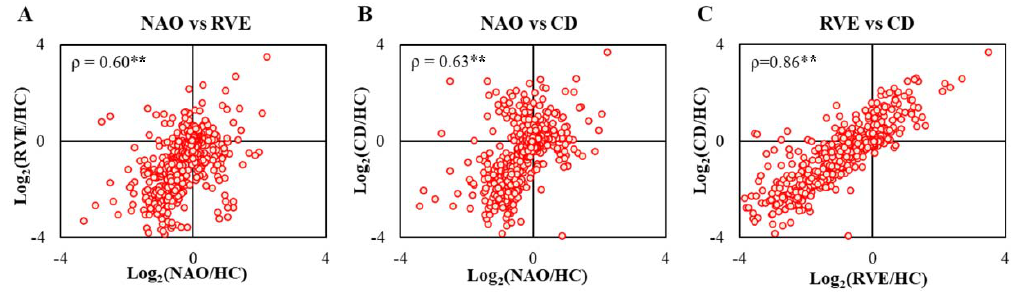
Figure 4. Proteome-wide Spearman rank correlation analysis in between three groups of LACI patients; ( A ) NAO vs. RVE, ( B ) NAO vs. CD, ( C ) RVE vs. CD. Log ratios of all confidently quantified proteins (n = 573) compared to HC (Log 2 (NAO/HC), Log 2 (RVE/HC), Log 2 (CD/HC)) were used for this analysis. The plots were presented with an axis value of − 4.0 to +4.0 for better visualization. ρ , Spearman rank correlation; ** p < 0.01 (two ‐ tailed).